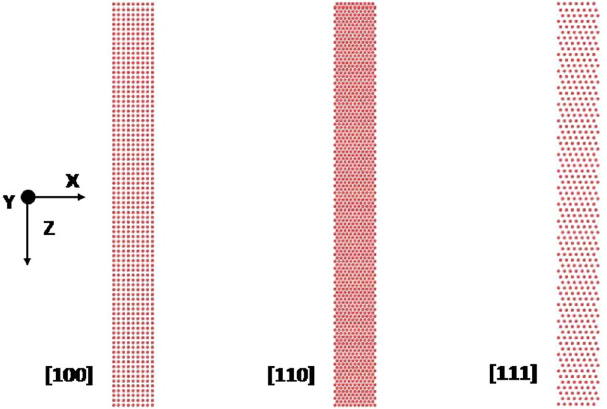
Figure 1. Atomic models of copper films with 〈 100 〉 , 〈 110 〉 and 〈 111 〉 crystal orientation along thickness